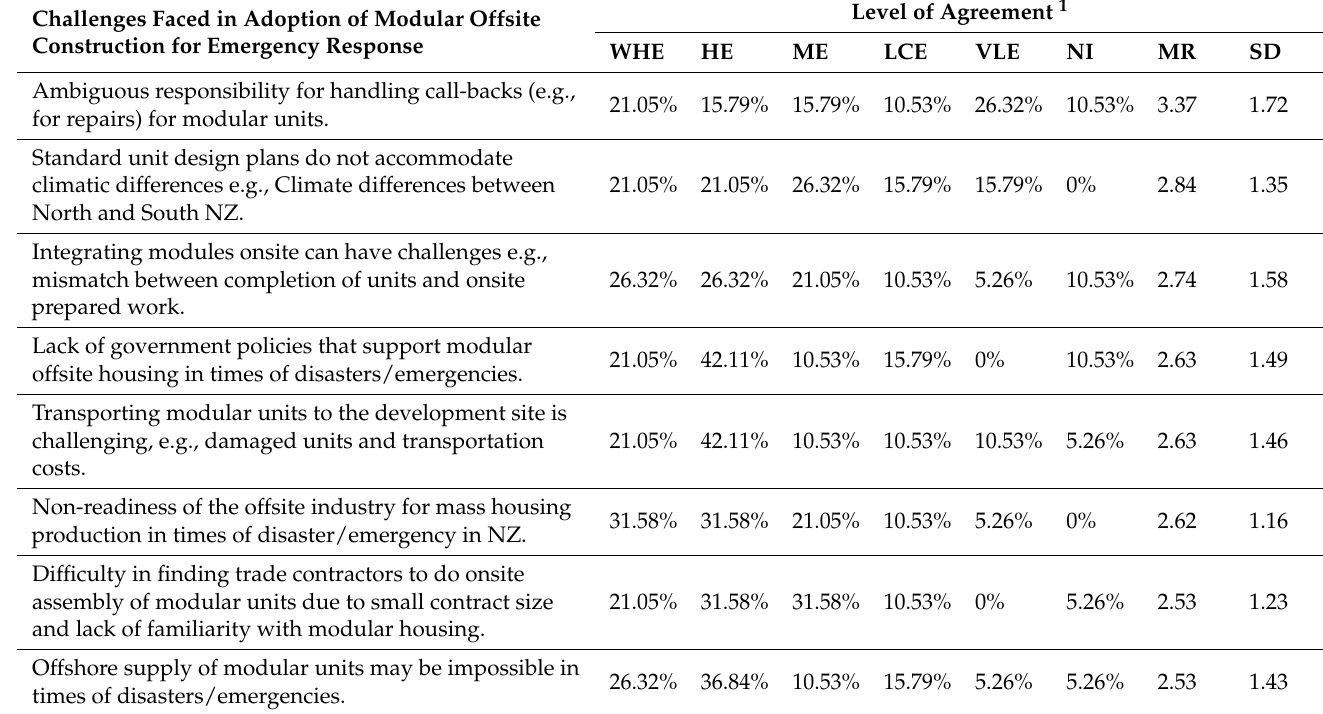
Table 6. Challenges associated with modular offsite construction for emergency